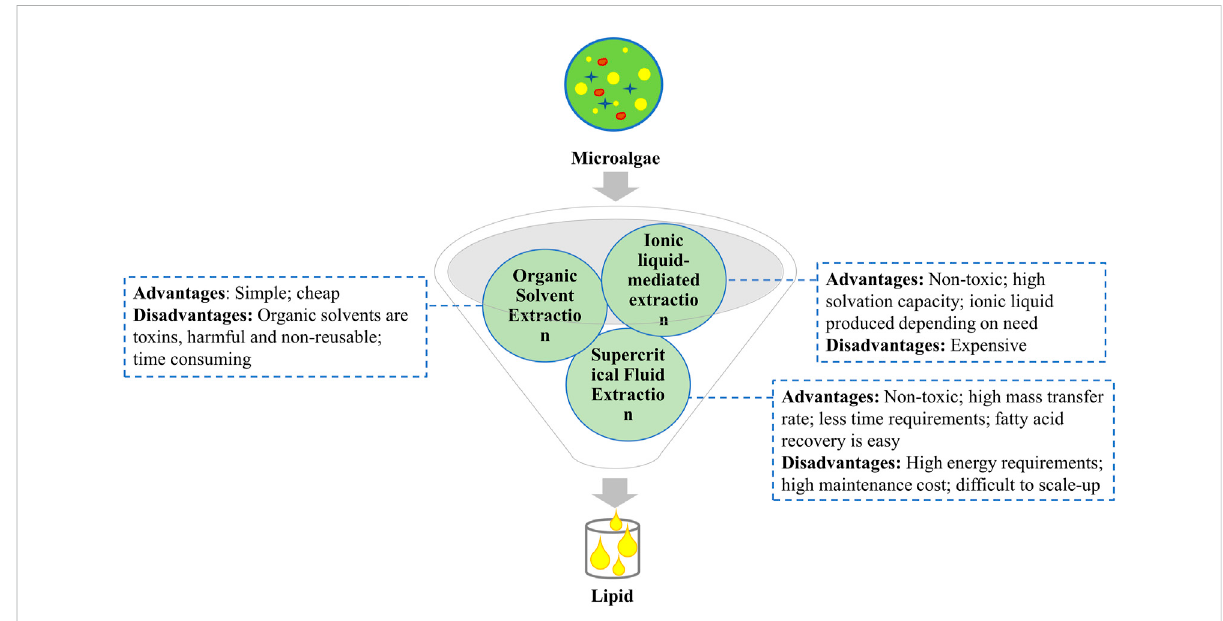
FIGURE 4 Advantages and disadvantages of lipid extraction